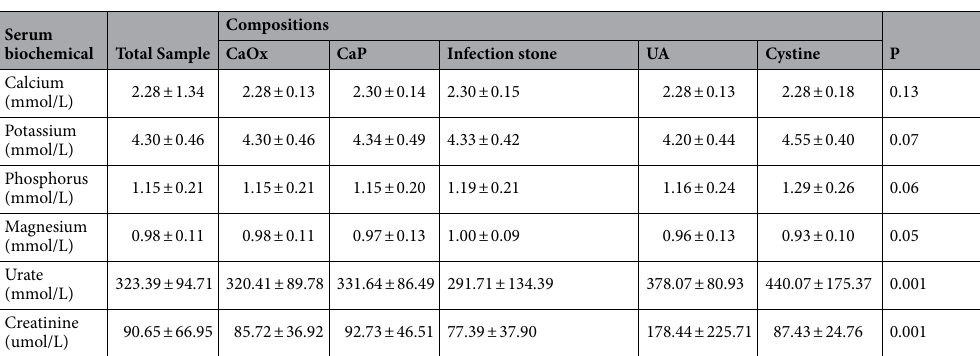
Table 5. Serum biochemical values of all type stones forming individuals. CaOx calcium oxalate, CaP calcium phosphate, UA uric acid.